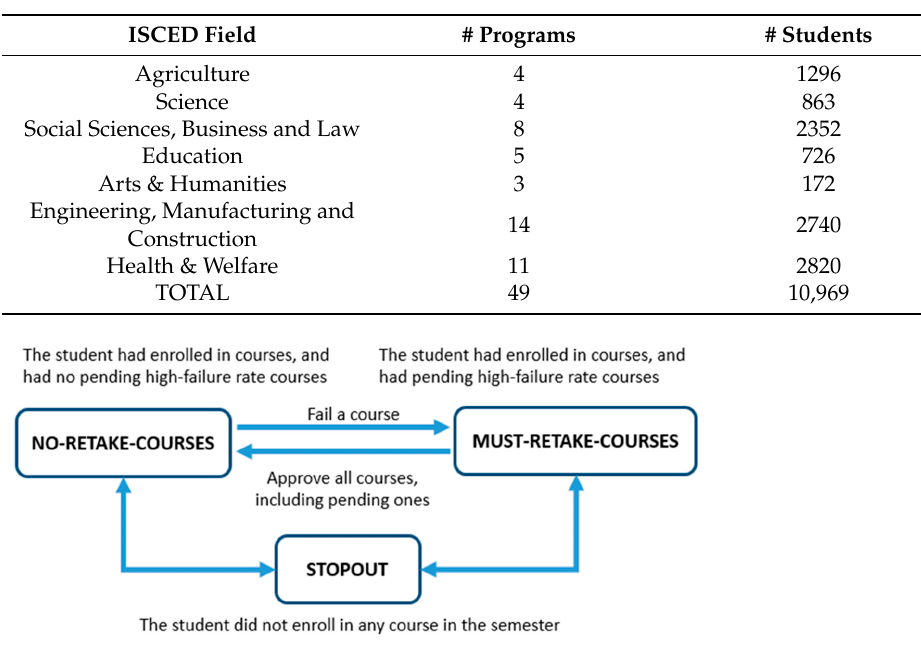
Table 2. Number of students for each International Standard Classification of Education (ISCED) field.